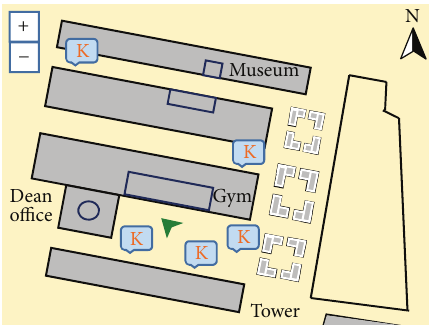
Figure 3: The map view of KioskAR including the available spots as well as spots that are already occupied by the kiosks.